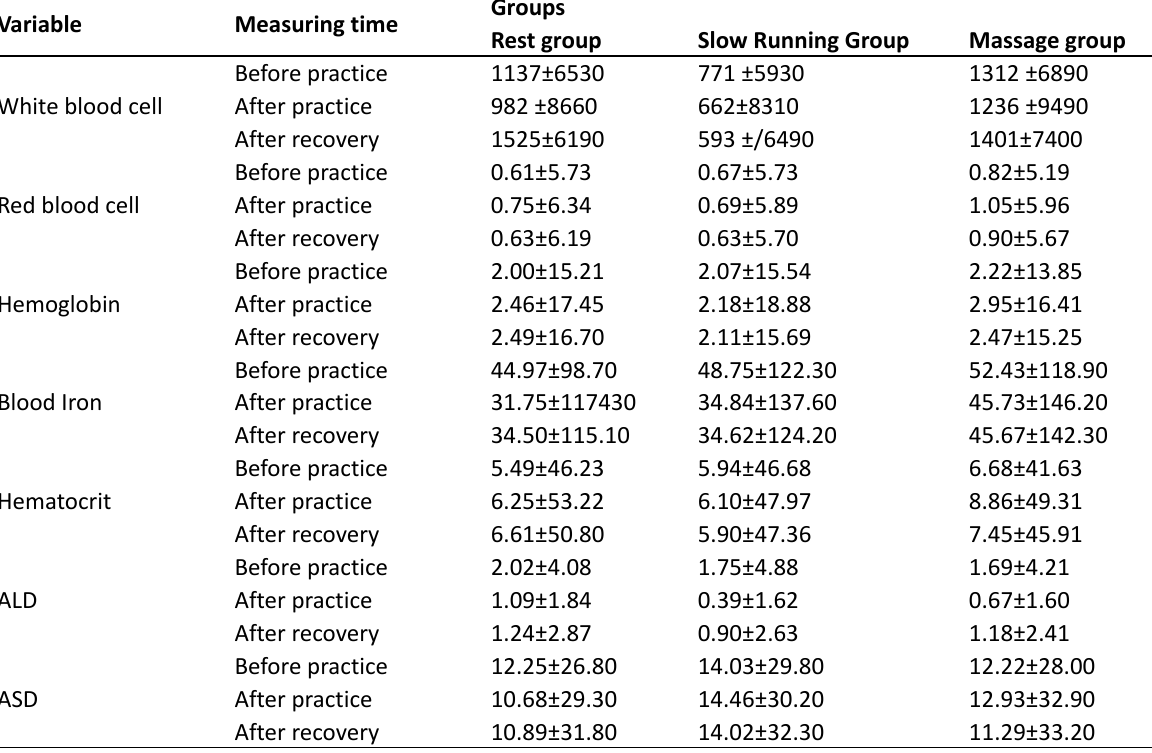
Table 1 . Pre-test, post-test and recovery of specific variables in study groups. Groups Measuring